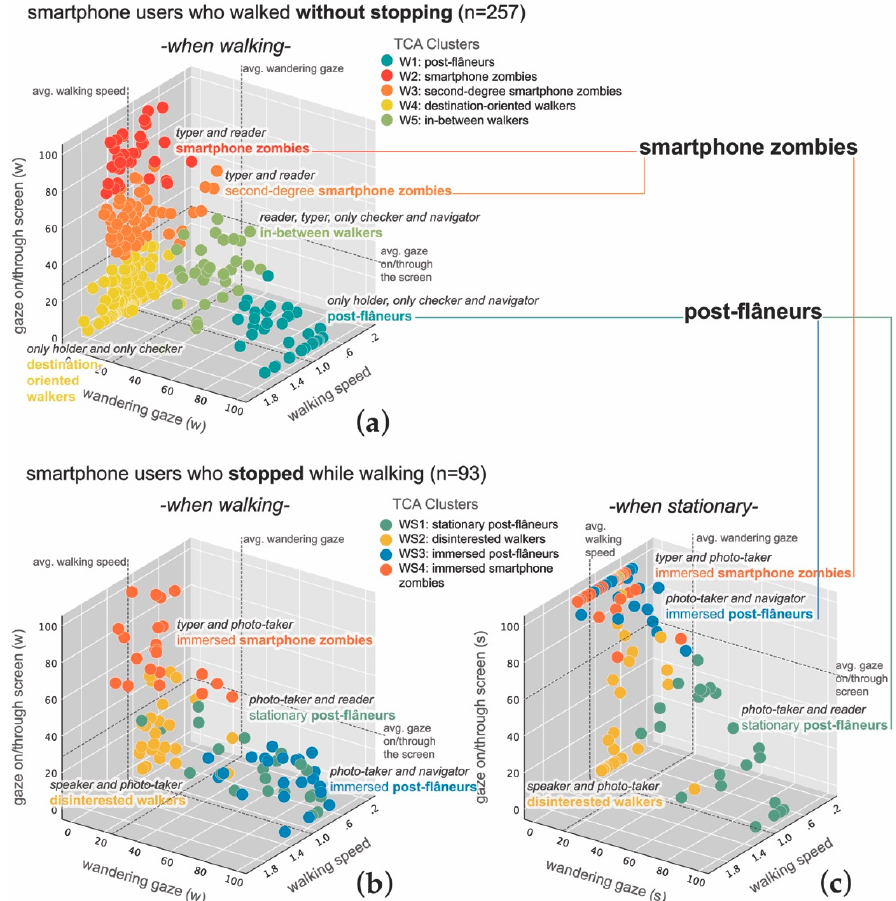
Figure 9. Three-dimensional scatter graphs of clusters generated by the two-step cluster analysis (TCA) within ( a ) smartphone users who walked without stopping and ( b , c ) who stopped while walking. The graphs represent the percentages of visual attention ( a , b ) when walking and ( c ) the stationary and walking speed of smartphone users. Scatter graphs were generated with SPSS (v25.0).